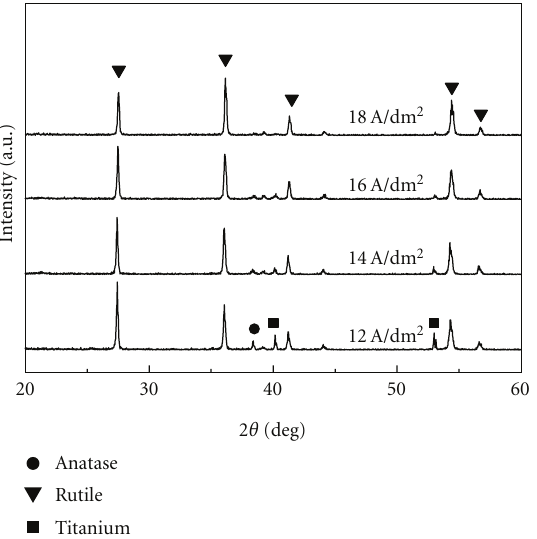
Figure 3: XRD of films prepared under di ff erent current